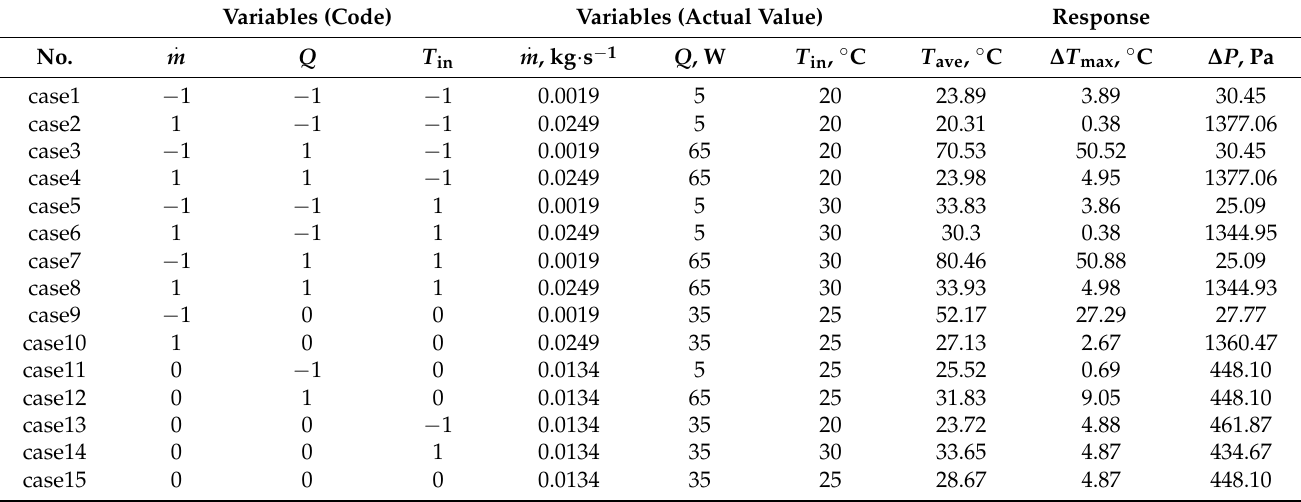
Table 2. Simulation design and corresponding